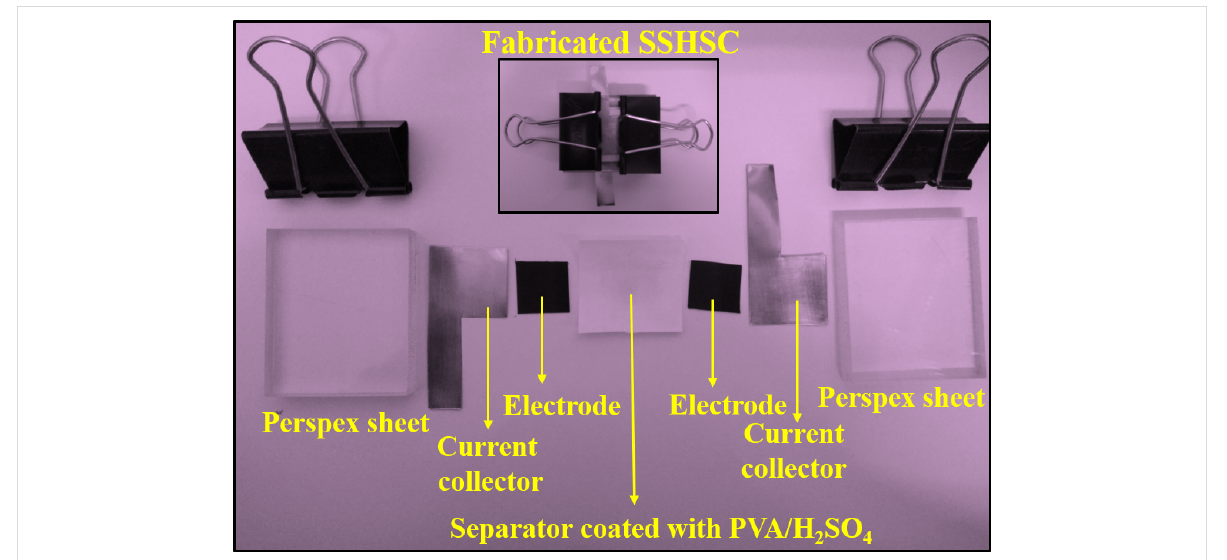
Figure 2: Photograph showing the different parts of fabricated symmetric solid-state hybrid supercapacitor (SSHSC).